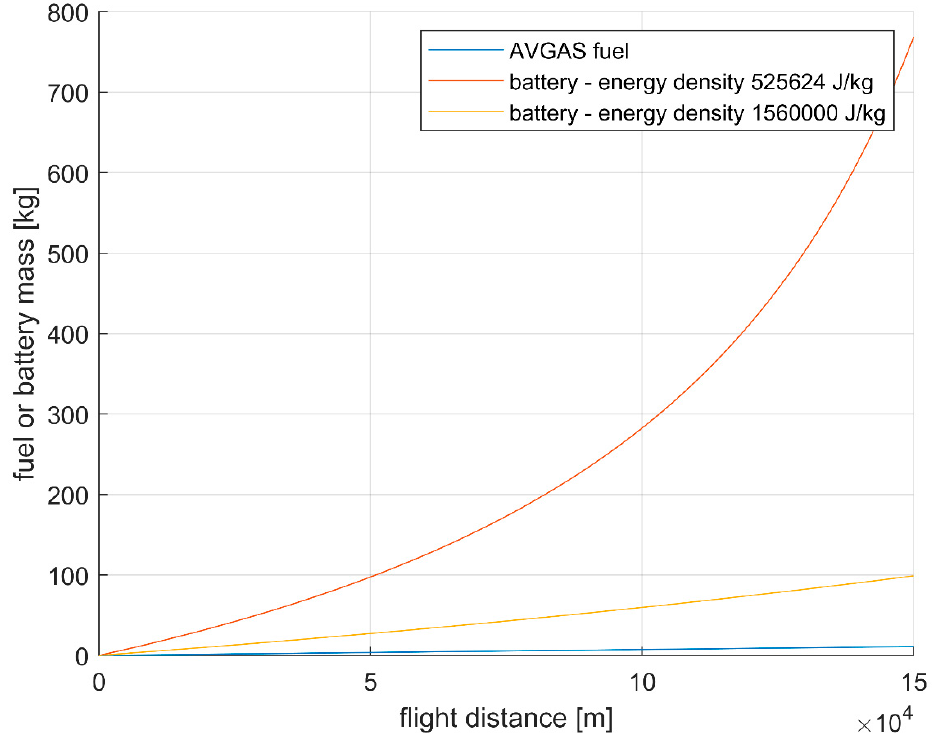
Table 1. Specific energy of batteries.